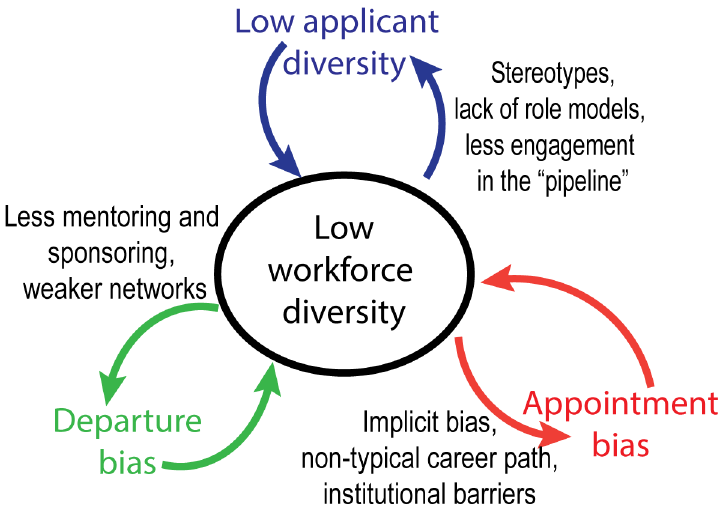
Fig 1. Low diversity can be reinforced by feedbacks with three measures of inclusion: applicant diversity, appointment bias and departure bias.